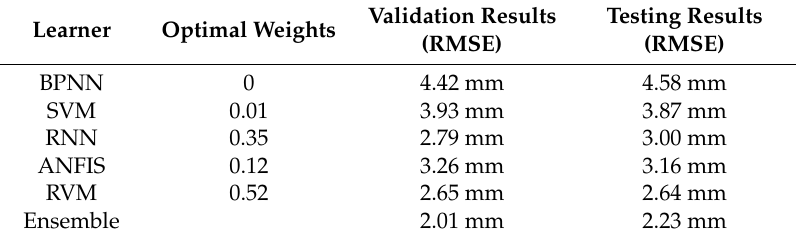
Table 4. Prediction